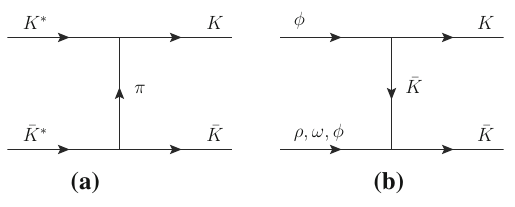
Fig. 5 Mechanisms for D + s → π + K + K − ( K 0 ¯ K 0 ) and D + s → (cid:7) π 0 K + ¯ K 0 . For π + f ( 1710 ) production V ≡ K ∗ ¯ K ∗ ,ωφ,φφ ; i V 0 i ≡ K ∗ ¯ K ∗ ,ρ 0 φ ; for for π + a 0 ( 1710 ) ( I 3 = 0 ) production V i V (cid:7) i (cid:7) π + a ( 1710 ) ( I = 1 ) production V ≡ K ∗ ¯ K ∗ ,ρ + i V 0 3 i